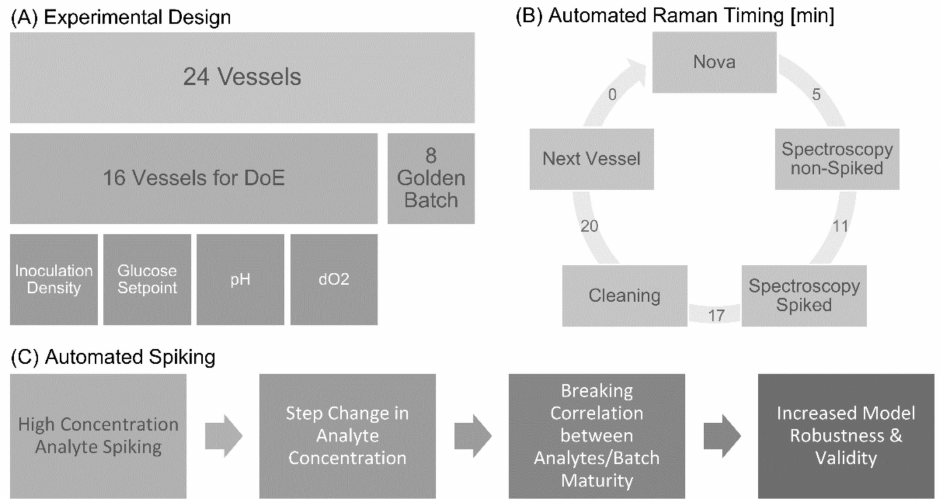
Figure 2. Experimental design and data acquisition of Ambr ® 250 runs to generate Raman spectra and reference analyte data. ( A ) In 16 DoE vessels, inoculation density, as well as glucose, pH and dissolved oxygen setpoint were varied, while process settings were kept constant in the 8 Golden Batch vessels, which served as control replicates. ( B ) Schematic diagram illustrating automated data acquisition and duration. Notably, the time gap between the FLEX2 reference measurement and Raman spectroscopy of the non-spiked sample is only 5 min. ( C ) Schematic diagram illustrating that automated spiking leads to increased model robustness and